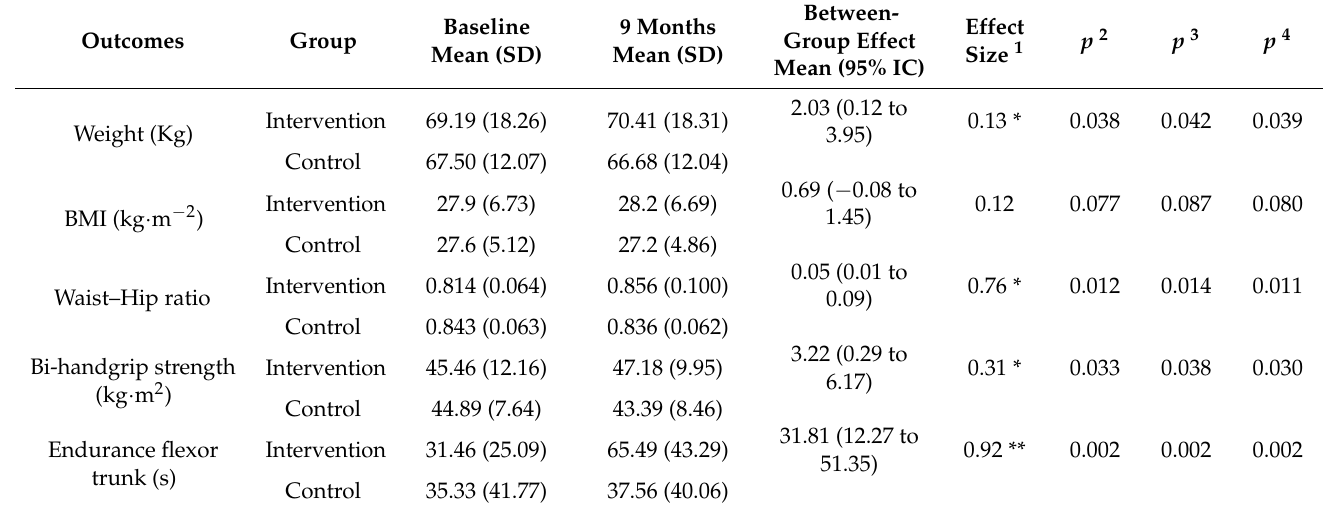
Table 3. Physical fitness at baseline and after 9-month